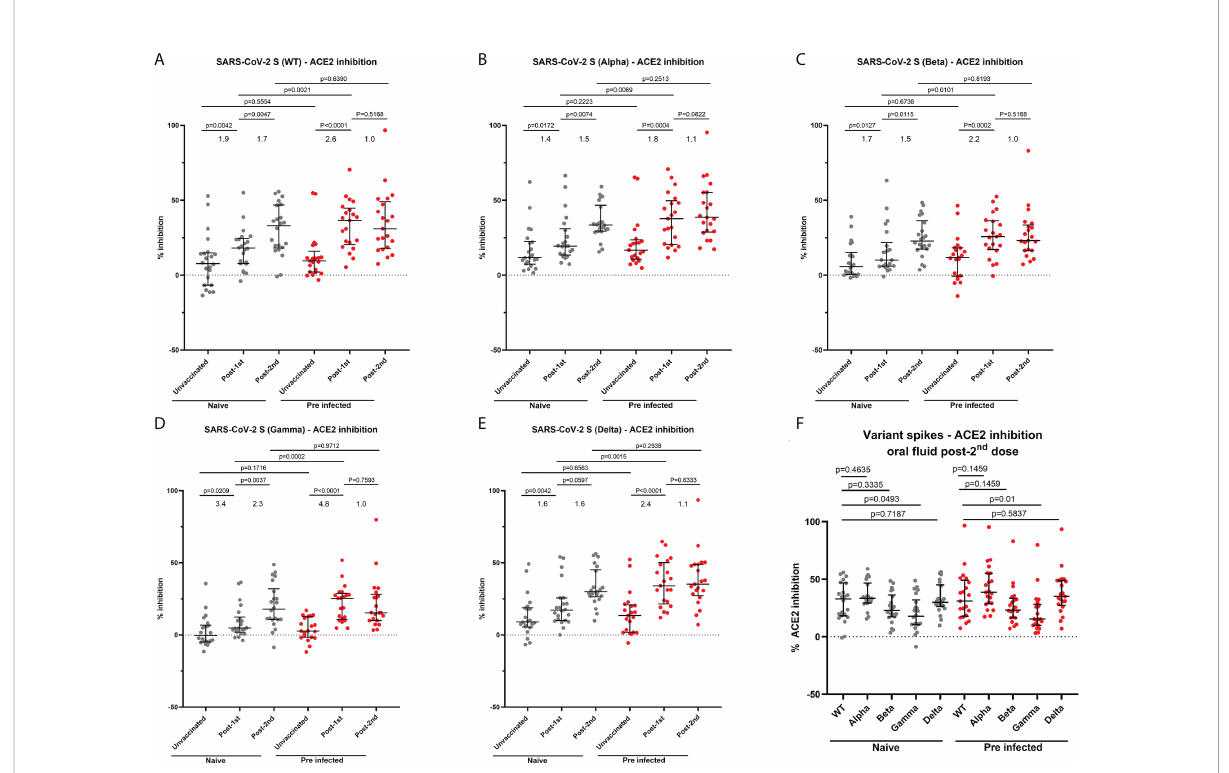
FIGURE 6 Ability of oral fl uid samples to inhibit ACE2 binding to different variants of SARS-CoV-2 spike. (A – E) Inhibition of ACE2 binding to SARS-CoV-2 spike Wuhan (WT), B 1.1.7 (Alpha) (B) , B 1.351 (Beta) (C) , P.1 (Gamma) (D) and B 1.617.2 (Delta) (E) by matched oral fl uid from naïve and previously-infected individuals determined using MSD ® ACE2 inhibition assay. (F) Comparison of ACE2 binding inhibition to SARS-CoV-2 variant spike antigens post-2 nd dose. Wilcoxon and Mann-Whitney tests were used to determine the statistical signi fi cance between the groups of paired and unpaired samples,